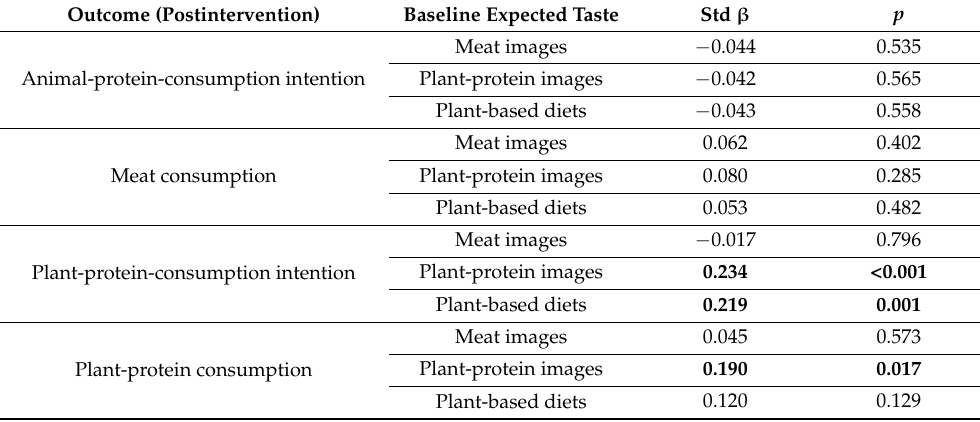
Table 1. Influence of baseline expected taste on changes in consumption intention and behavior.